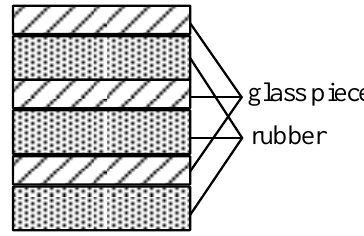
Figure 10. Illustration of layered